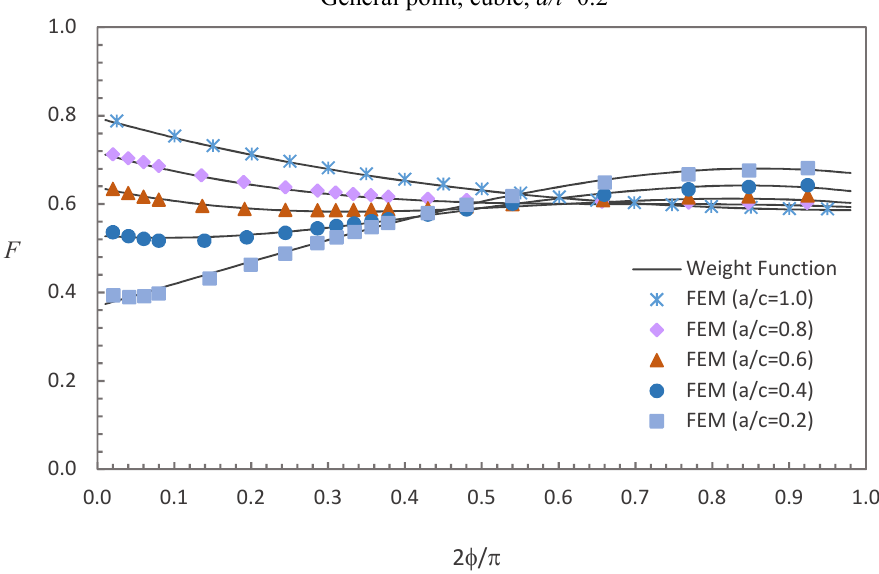
Figure 10. Comparison of weight function and FE results in this study with cubic stress distribution (general point).